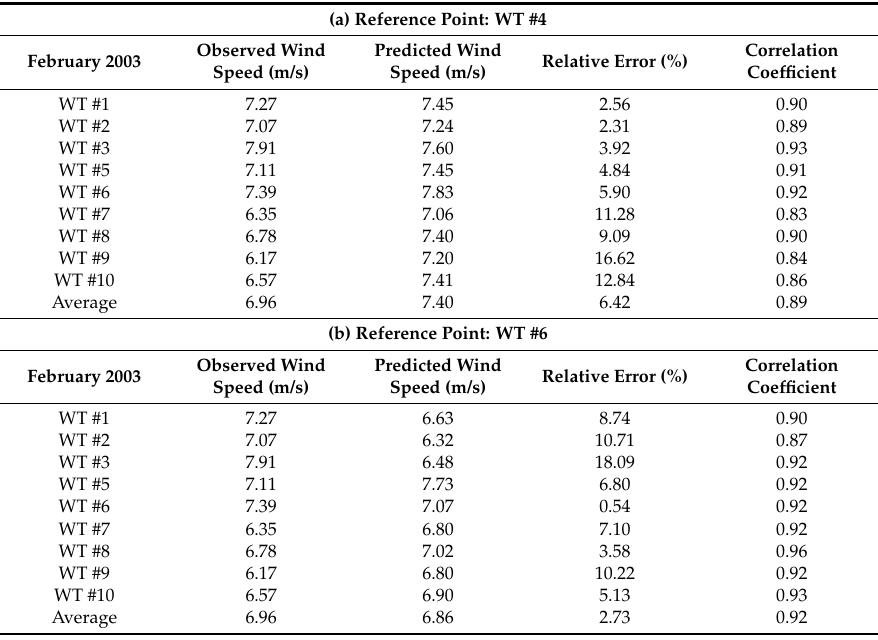
Table 3. Comparisons of observed and predicted values of wind speed.